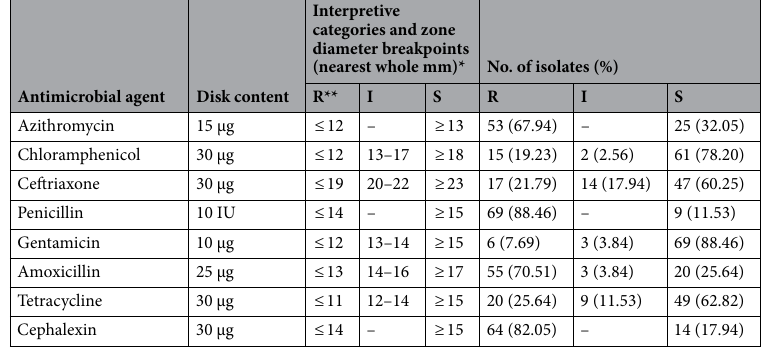
Table 2. Antibiotic resistance profile of Escherichia coli isolates (n = 78) from bovine milk samples. *From CLSI 31 . ** S susceptible, I intermediate, R resistant.